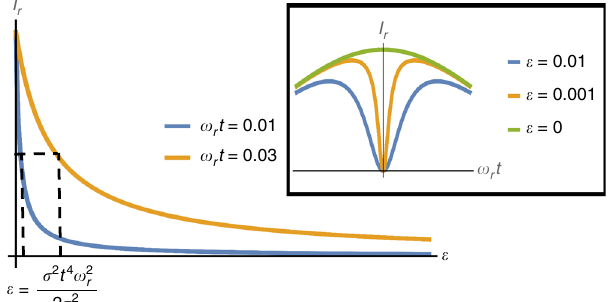
as a function of ϵ (a general noise term in the r